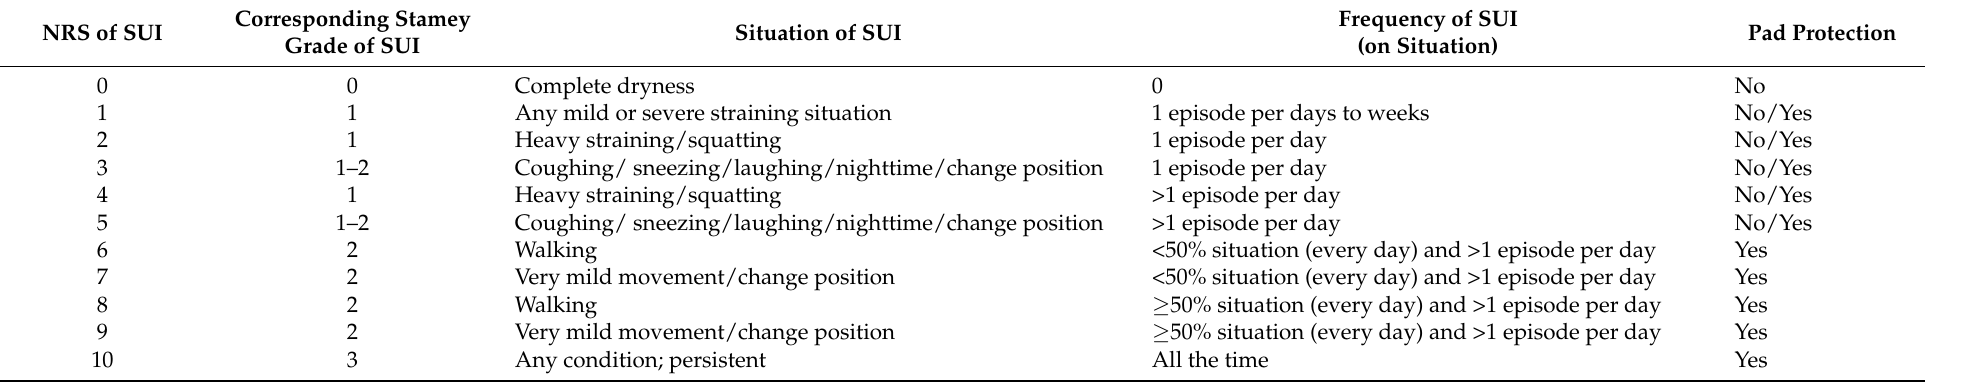
Table 1. Visual analogue scale (VAS) for assessment of stress urinary incontinence